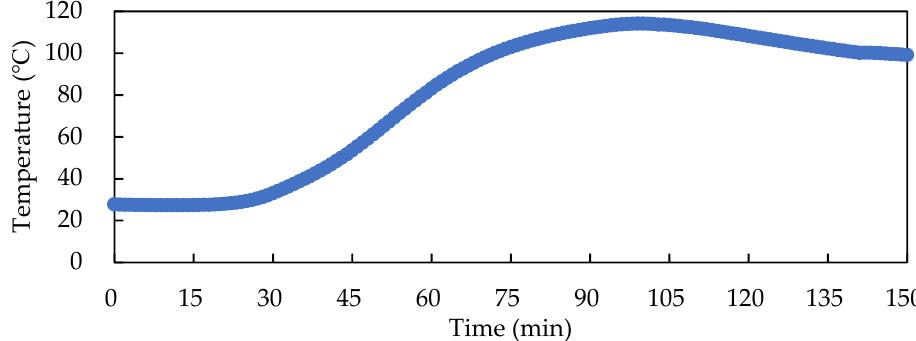
Figure 5. Center temperature profile of 500 g of solid-state fermented W. cocos product during 121 °C autoclaving for 60 min and cooling.